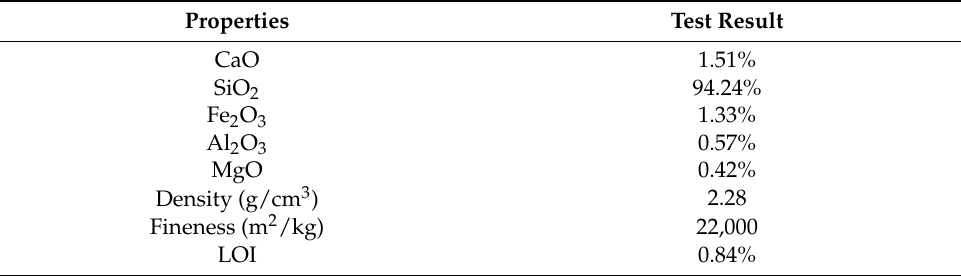
Table 3. Properties of Silica